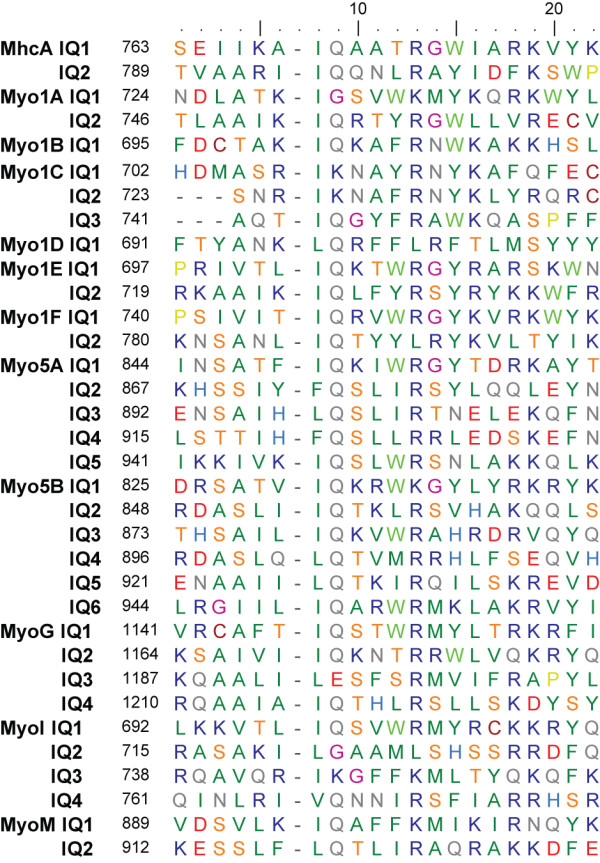
Alignment of the putative IQ motifs of the Dictyostelium myosins. The alignment shows the IQ motifs of the myosins. The numbers at the beginning indicate the position in the full-length sequence. The gap has only been introduced to facilitate the identification of the IQ residues.